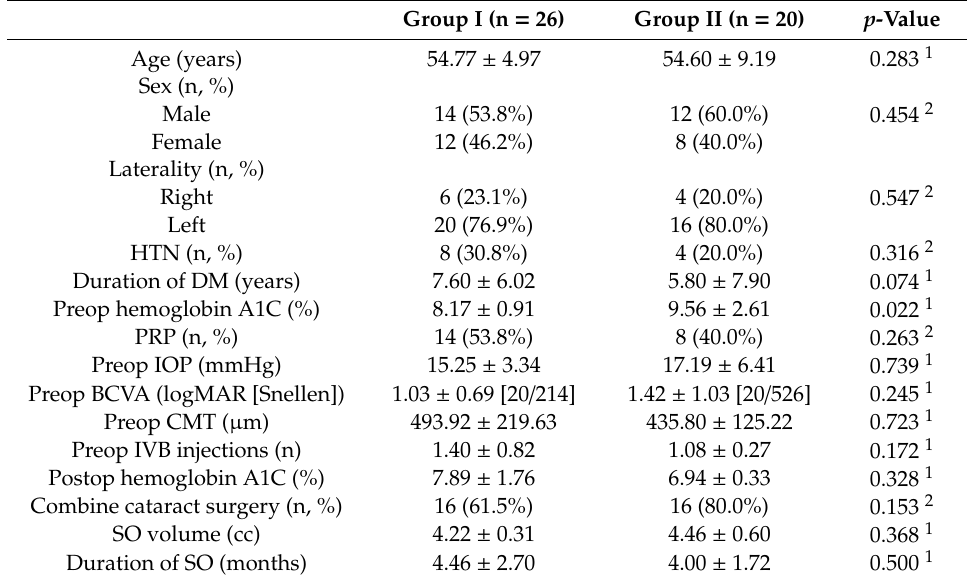
Table 1. Patient Demographics and Clinical